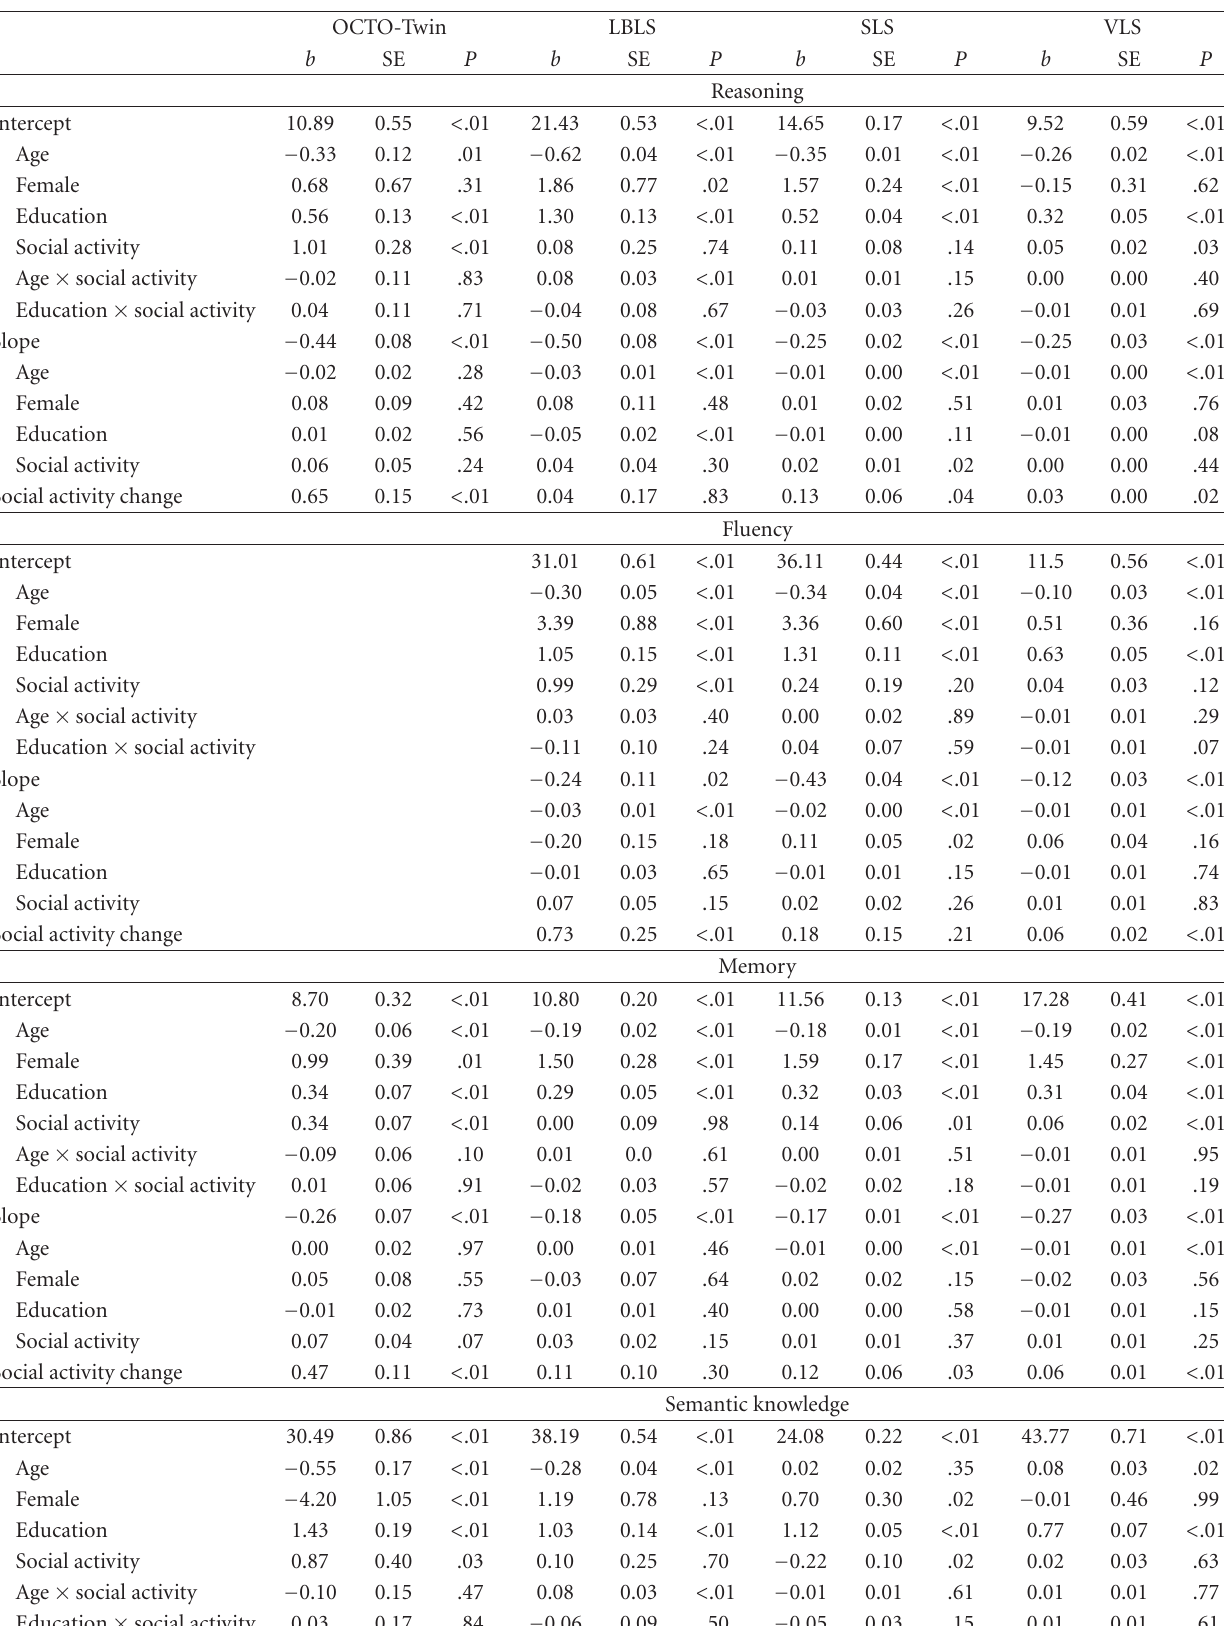
Table 5: Mixed model results of four longitudinal